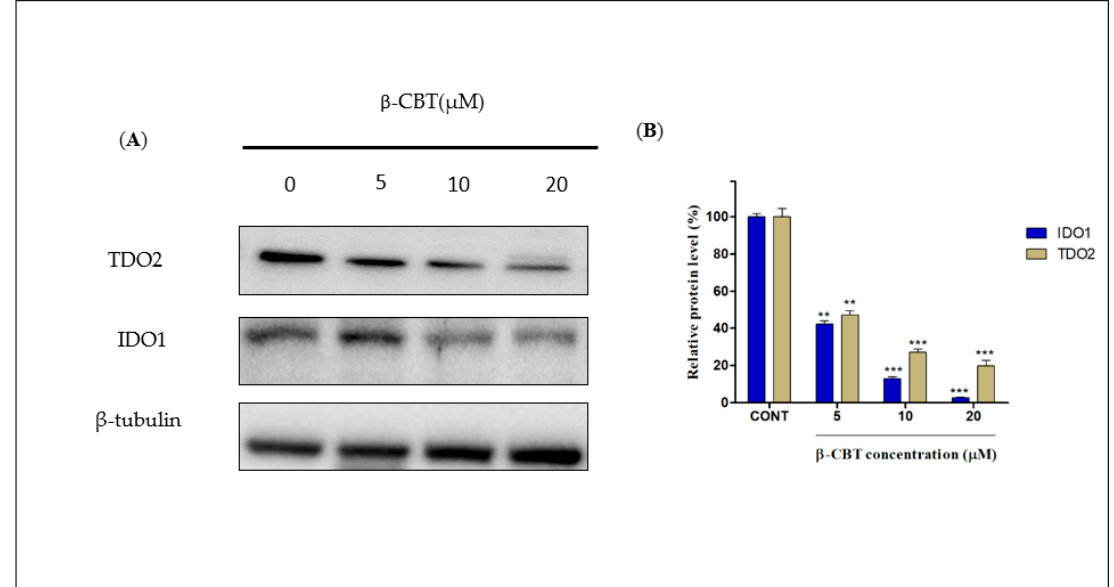
Figure 4. Effect of β -CBT treatments on the expression levels of IDO1 and TDO2 in PC-3M prostate cancer cell lines. ( A ) Immunoblots of IDO1 and TDO2 in cells treated with the vehicle control and 5, 10, and 20 μ M β -CBT over 24 h. ( B ) Densitometric analysis of IDO1 and TDO2 expressions in PC-3M cells. Scanning densitometry was obtained for all blots, carried out in triplicate, and the integrated optical density of each band was normalized to β -tubulin in the same blot. Bar graphs represent mean relative protein expression percent (± SD). ** p < 0.01 and *** p < 0.001 for statistical significance vs. respective vehicle-treated controls.